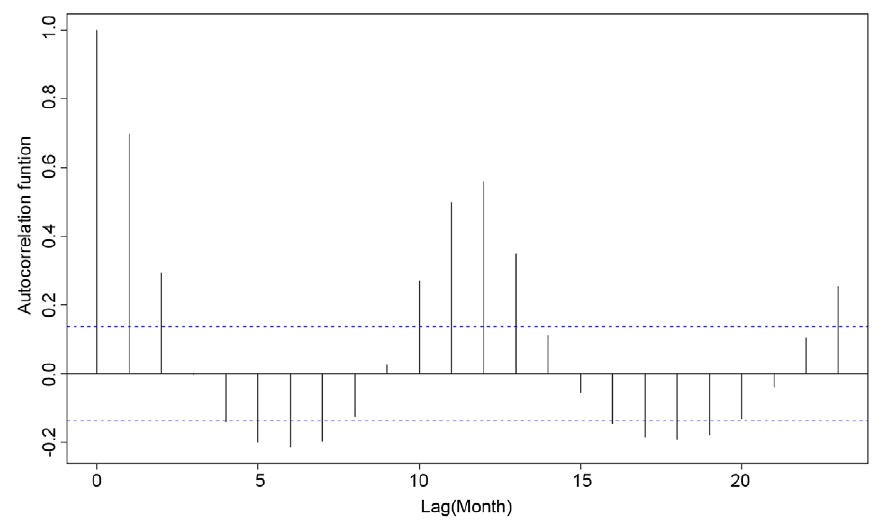
Figure 3. Autocorrelation Function (ACF) of monthly ZCL incidence.